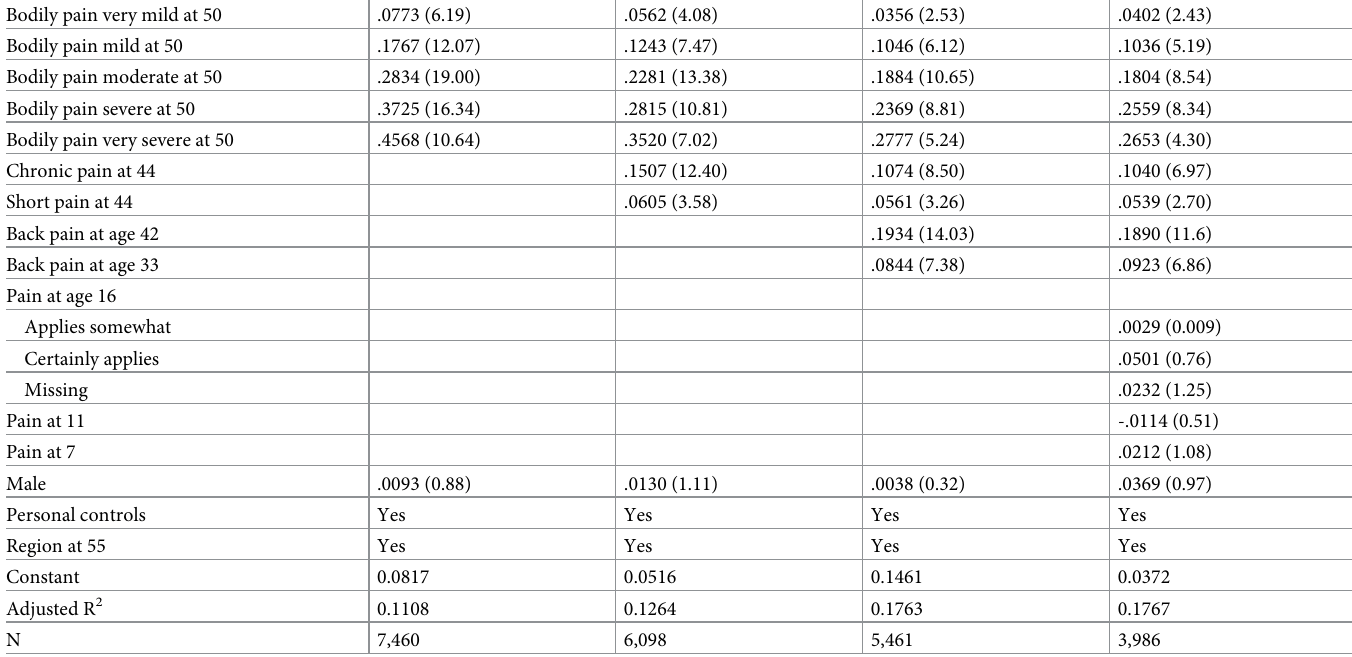
Table 10. Backache, sciatica, disk prolapse and pain lasting > one day–NCDS9 at 55 (OLS).